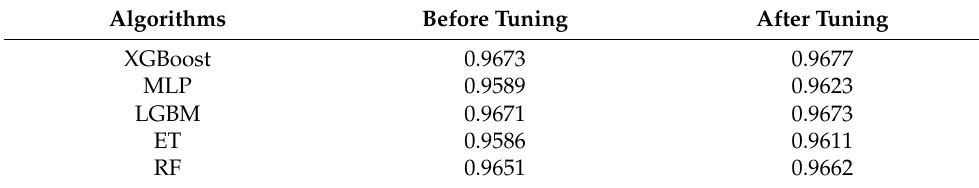
Table 3. Performance of classification algorithms before and after hyper-parameters